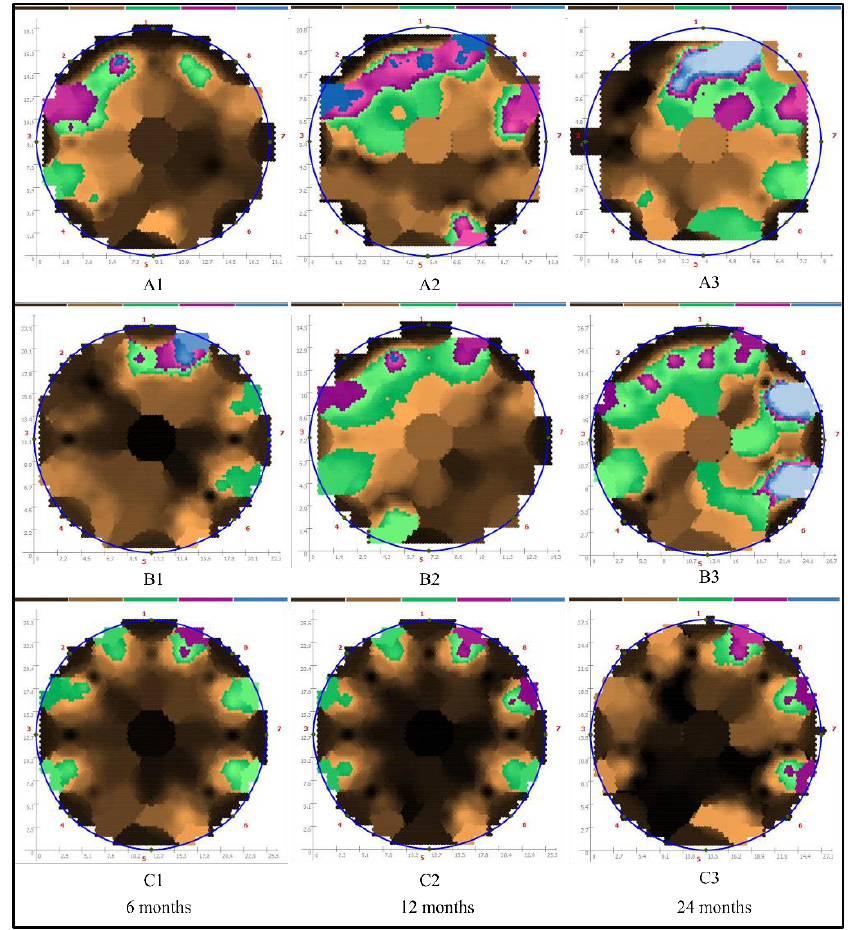
Figure 7. Detection of Discolouration Zone by Tomogram Colour Images Matched with the Internal Sapwood Areas’ Condition of A. malaccensis trees. Note: ( A1 – A3 ) = inoculated with P. kudriavzevii , ( B1 – B3 ) = inoculated with P. niveus , ( C1 – C3 ) = control (uninoculated) trees. These tomogram colour images were taken in the middle of the selected medium-class diameter, representing each treatment.